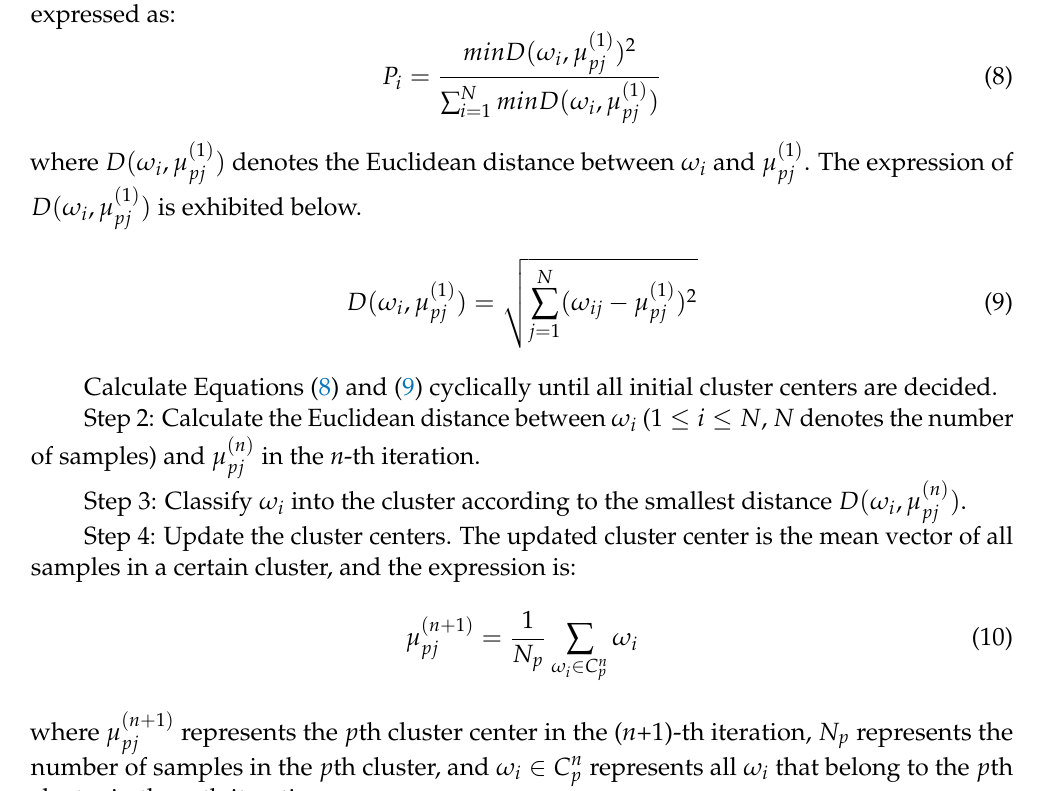
algorithm selects the initial cluster centers by two calculation procedures: the first procedure is to select one sample from the dataset indiscriminately as one initial cluster center; the second procedure is to determine the shortest distance between each sample and the existing cluster centers. Then, the roulette method is applied to determine the next